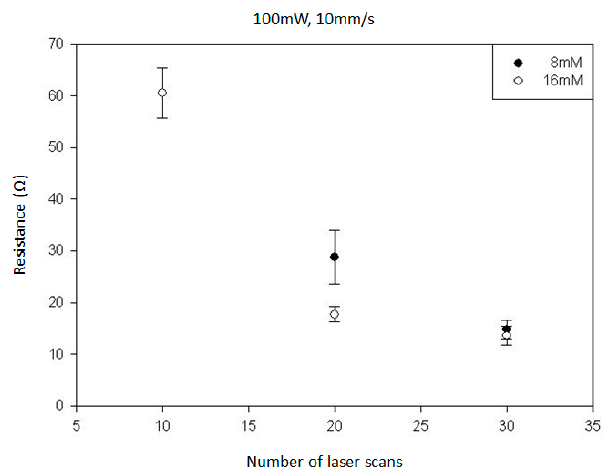
Figure 4. Electrical resistivity of silver lines with respect to the red-dye concentration and number of laser scans.